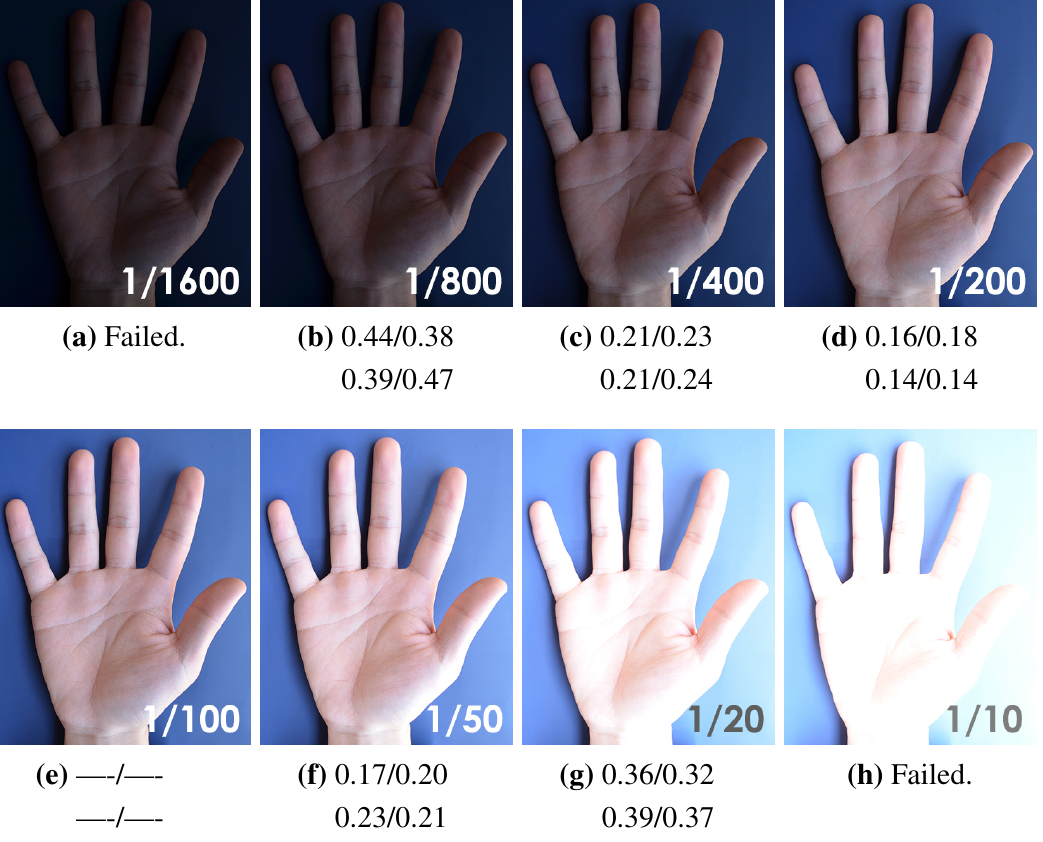
Figure 16. Comparison under different exposures. All images are captured by a Nikon D7000 camera with a F5.0 aperture. The values located in the right bottom corner of the images are the exposure time (in seconds). The four values under each image indicate the matching distances of the four IKP ROIs against (e), which is considered to be under perfect illumination conditions, respectively. The threshold applied here is 0.41, the same as in Figure